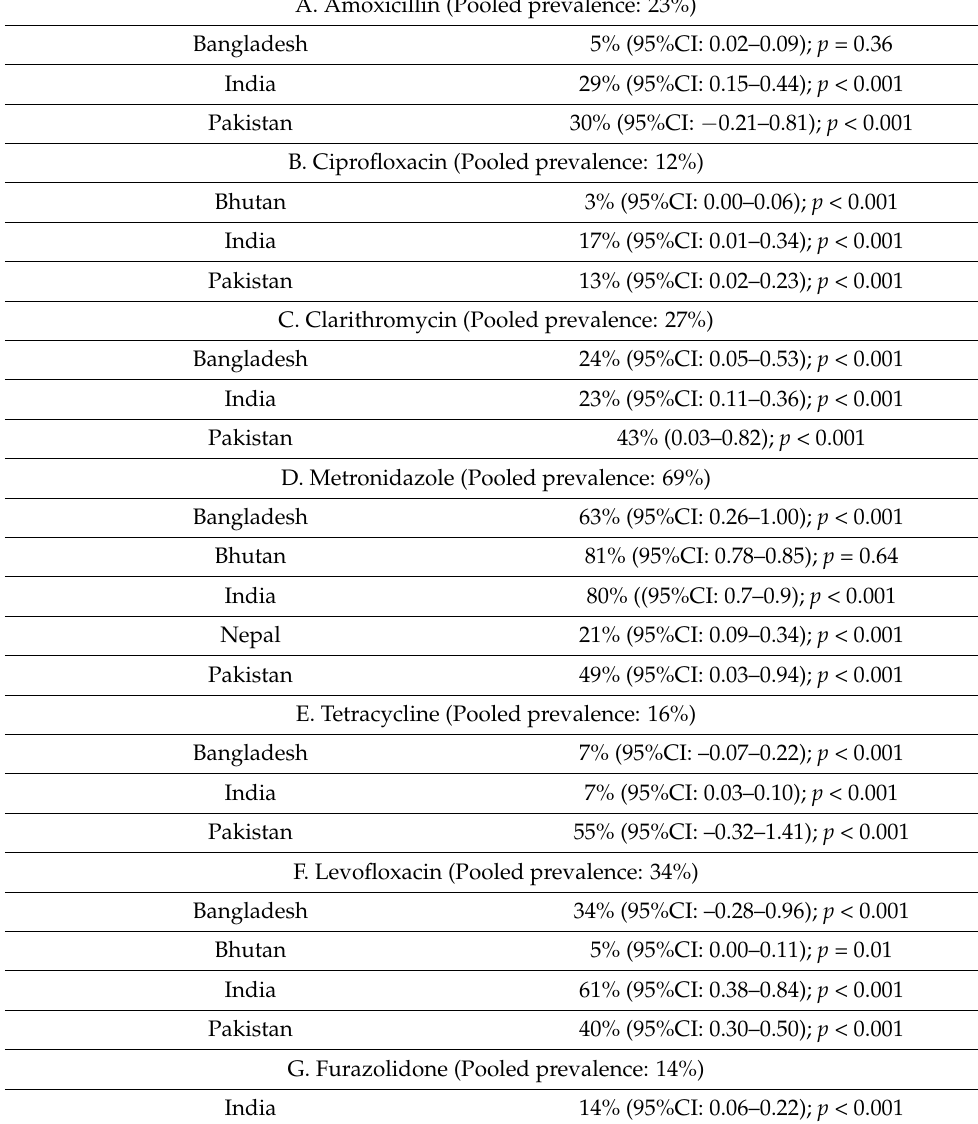
Table 2. Country-wise Antibiotic Resistance